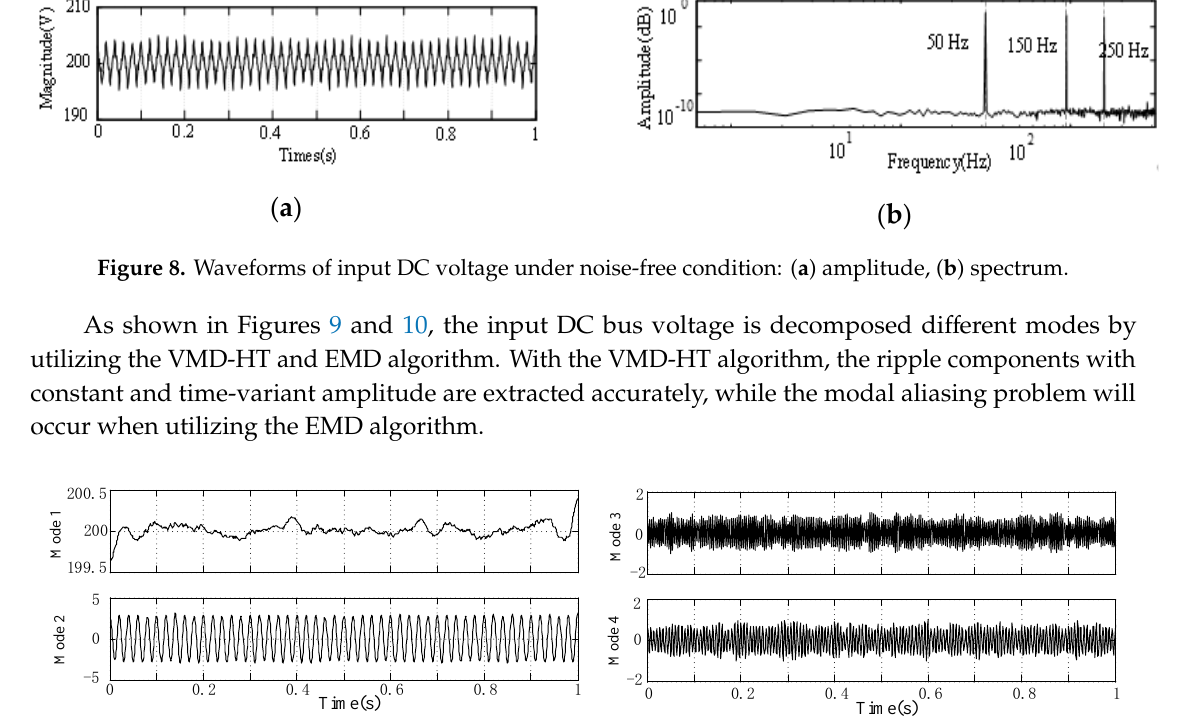
Figure 9. The decomposed modes of VMD-HT algorithms.